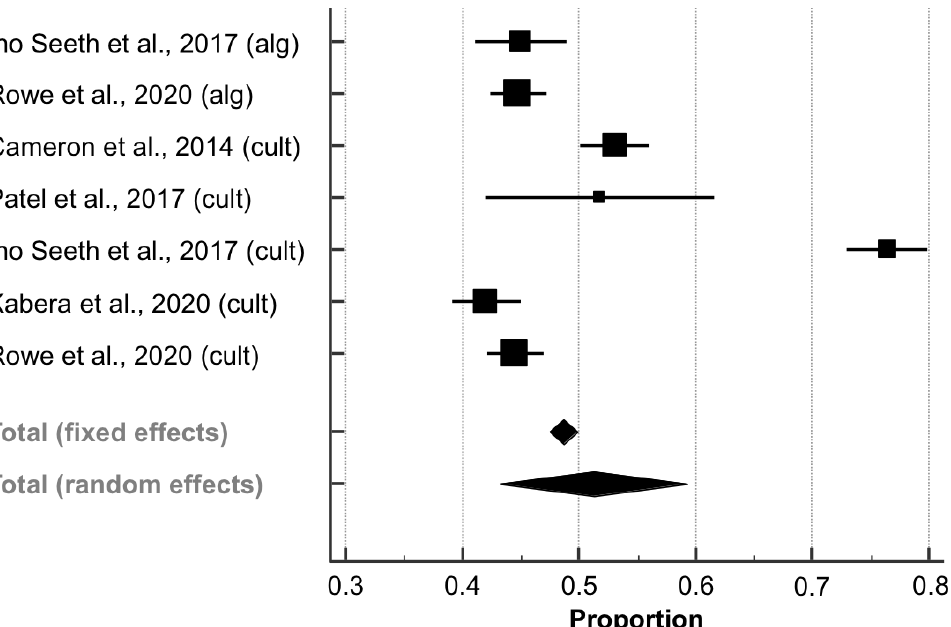
Figure 6. Antibiotic use at drying-off within algorithm-guided (alg) and culture-based (cult) selective dry cow treatment groups. The effect size of each study was summarized into a pooled proportion (solid squares) and its 95% confidence interval (CI; whiskers) using a random-effects model. Overall effect size estimates and corresponding 95% CI are represented as the middle of the diamonds and their widths, respectively.